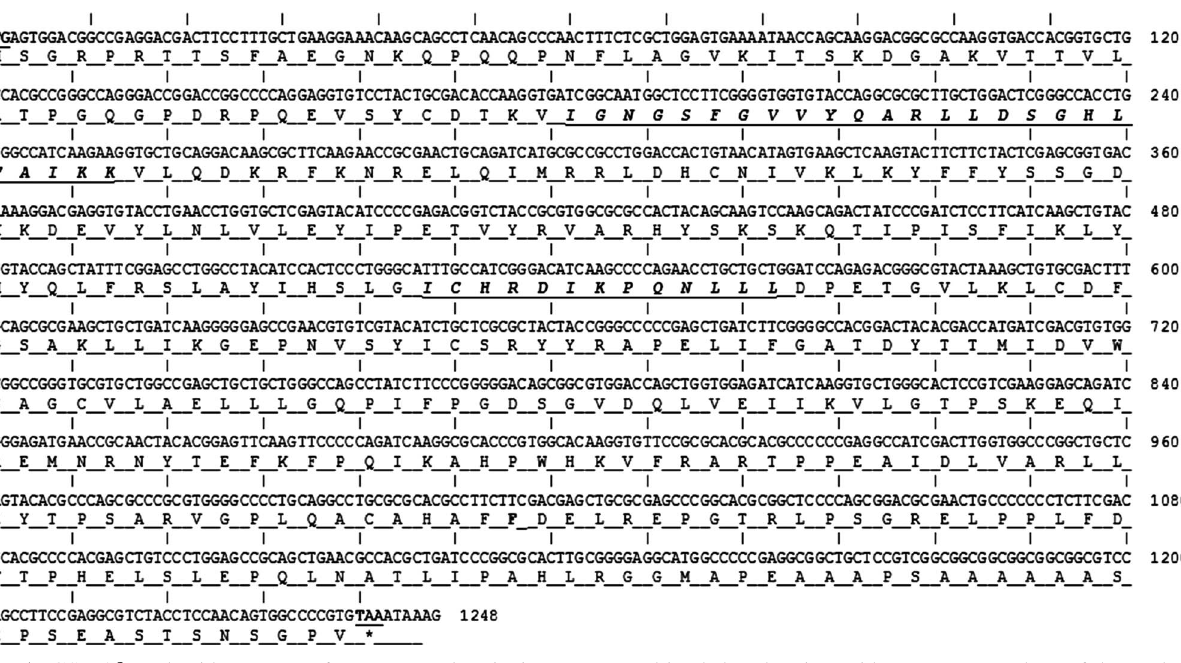
Figure 1. GSK-3 b nucleotide sequence from Haemaphysalis longicornis and its deduced amino acid sequence. Numbers of the nucleotide sequence are on the right side. One protein kinase domain was found between amino acid residues 55 and 339. ATP binding sites located between residues 61 and 85 are shown in underlined bold letters. The serine/threonine protein kinase active site located between residues 176 and 188 is also shown in underlined bold letters. Start codon and stop codon are highlighted with underlined bold